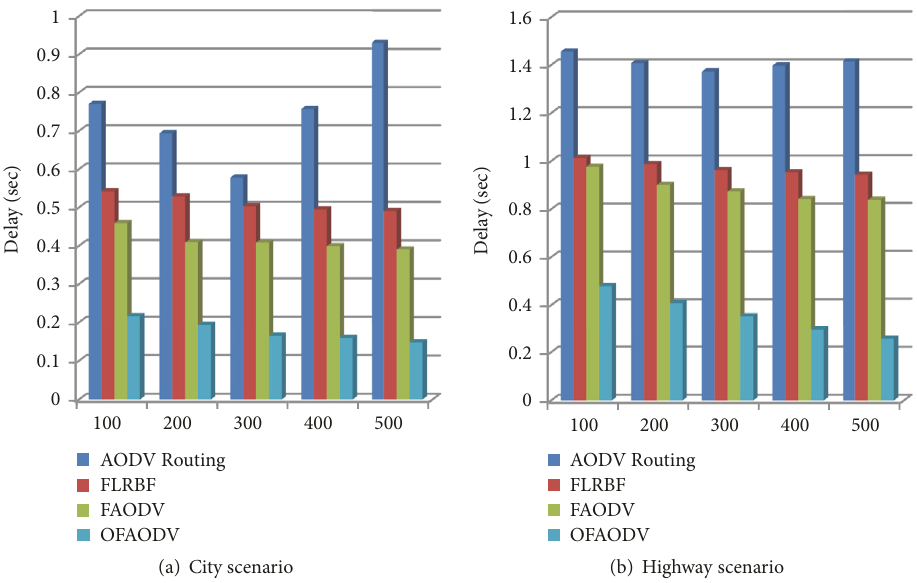
Figure 7: Mean delay (Sec) vs. no. of vehicles.